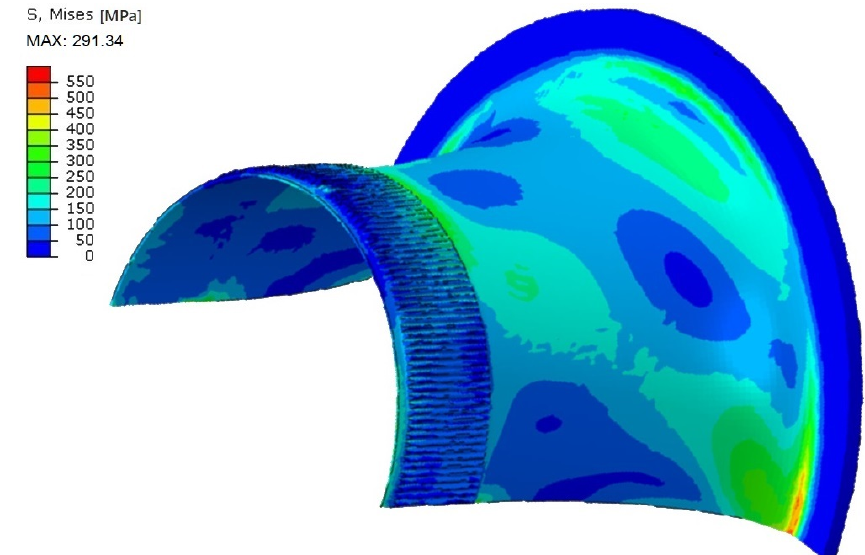
Figure 12. The distribution of the stresses in the flexspline model—variant VIII.